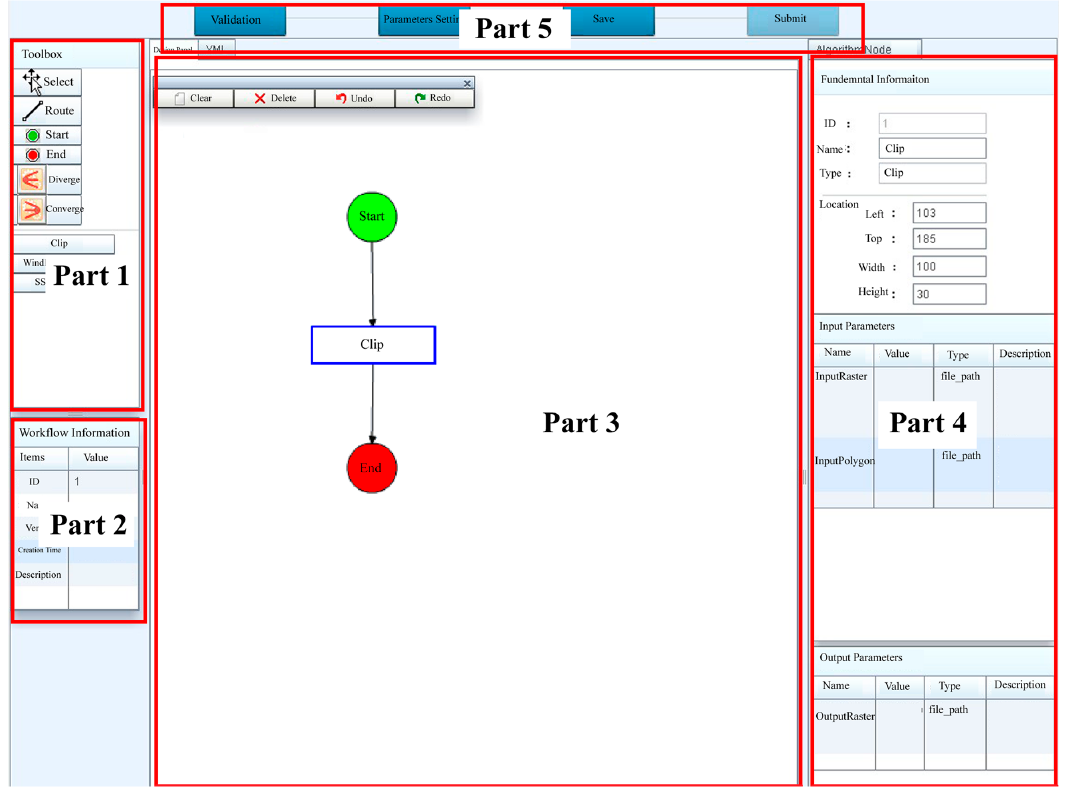
Figure 3. The Graphical User Interface ( GUI ) of designing a customized processing workflow.